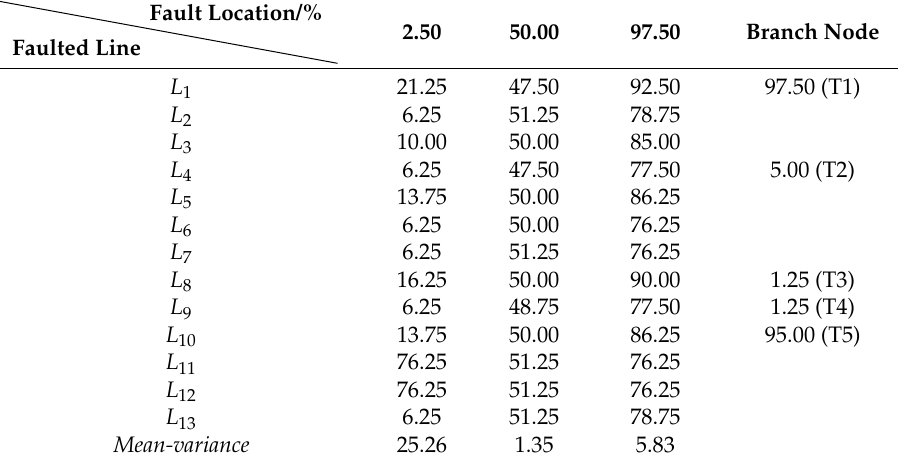
Table 2. Results of different fault locations for different fault